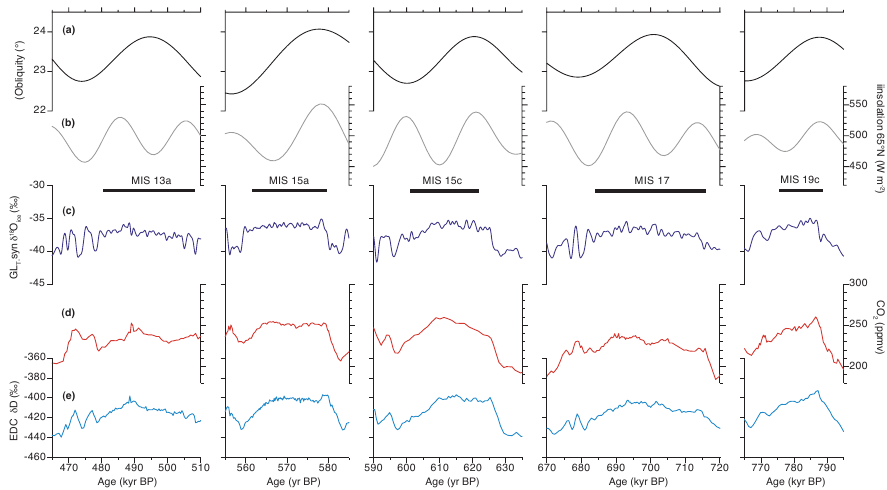
Fig. 4. Astronomical parameters and palaeoclimatic records for the interglacials corresponding to MIS 13a, 15a, 15c, 17 and 19c. Thick horizontal bands indicate estimated interglacial duration (see text). The onset of MIS 15c is placed at the second jump in the GL T − syn record (621kyrBP), rather than the first (626kyrBP) on the basis of comparisons with isotopic and IRD records from the North Atlantic (Hodell et al., 2008), showing that 626–621kyrBP is a complex deglaciation interval, with the terminal Heinrich event occurring at 621kyrBP. (a) obliquity (Laskar et al., 2004); (b) daily mean insolation at the summer solstice (21 June) at 65 ◦ N (Laskar et al., 2004); (c) Reconstructed δ 18 O composition of ice in Greenland synthetic (GL T − syn) record (Barker et al., 2011); (d) atmospheric CO 2 concentration in Antarctic ice cores (L¨uthi et al., 2008); (e) δ D composition of ice in the EDC ice core (Jouzel et al., 2007). Palaeoclimatic records are plotted on the EDC3 timescale of Parrenin et al.